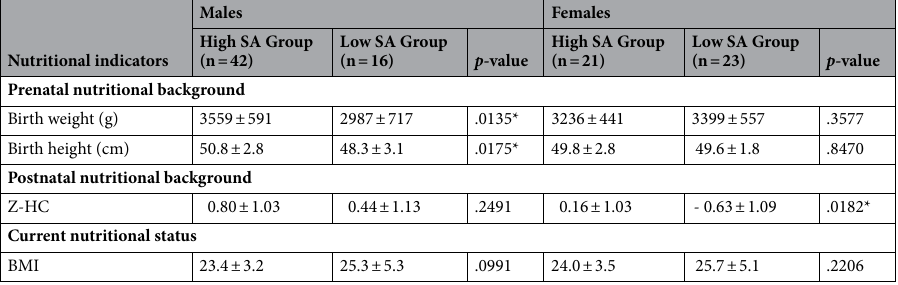
Table 2. Prenatal, postnatal, and current nutritional status by group and sex. Results are expressed as mean ± SD. Means were compared by Bonferroni’s test. SA: scholastic achievement; PSU: University Selection Test; High SA Group: High PSU scores (> 620, > p75); Low SA Group: Low PSU scores (< 450, < p25). Z-HC, head circumference-for-age Z-score; BMI: body mass index. p < .05 *; < .01**; < .001